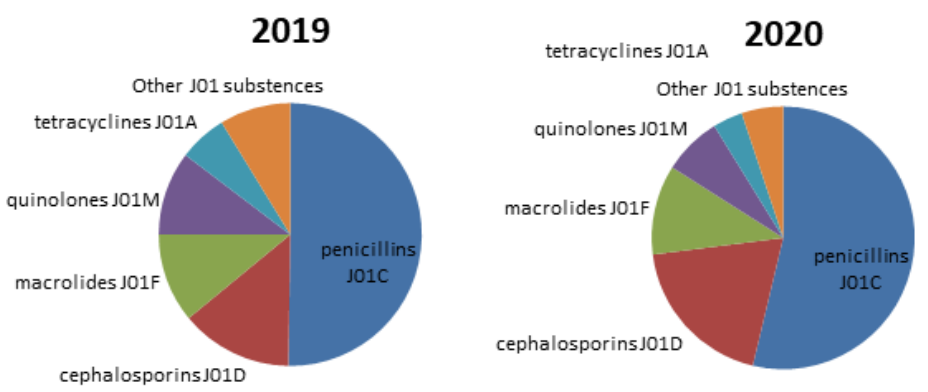
Figure 2. Distribution of consumption of different J01 groups of antibacterialsin 2019 and in 2020.